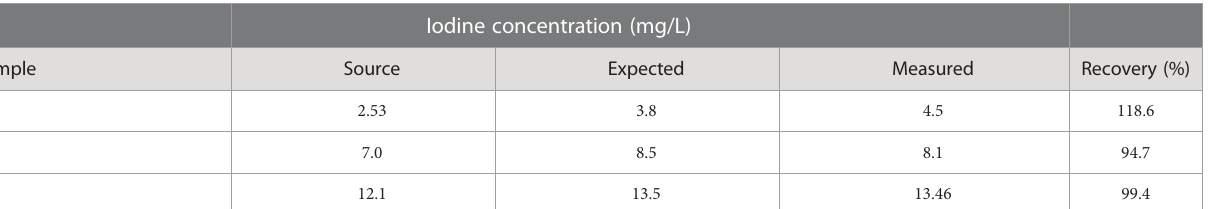
TABLE 4 Recovery of iodine added to soy